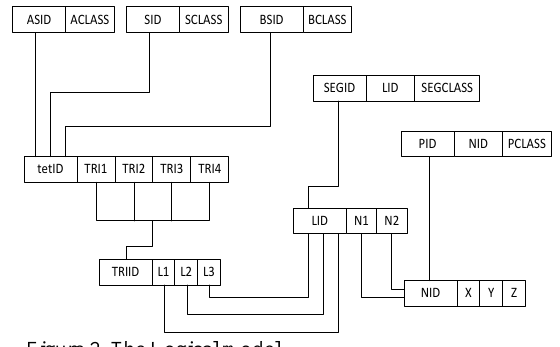
Figure 2. The Logical model